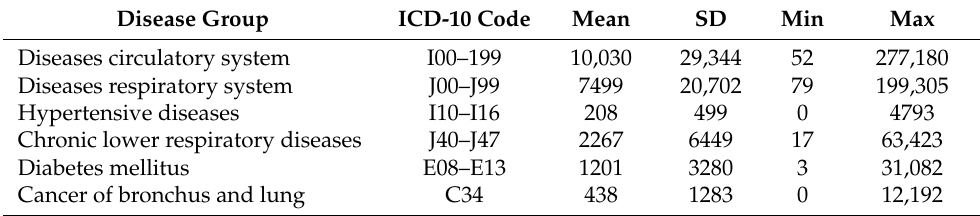
SD: Standard deviation. ICD-10: International Classification of Diseases 10th